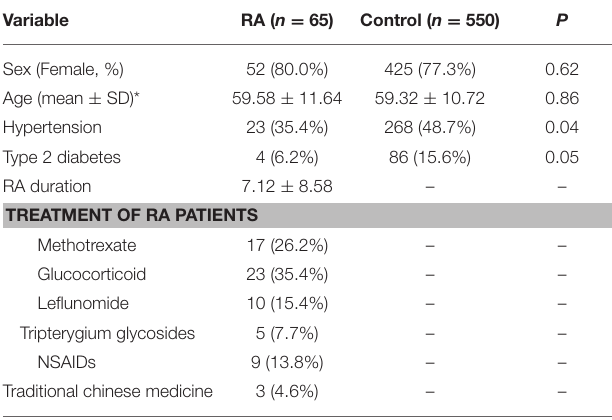
TABLE 1 | Characteristic of subjects in the